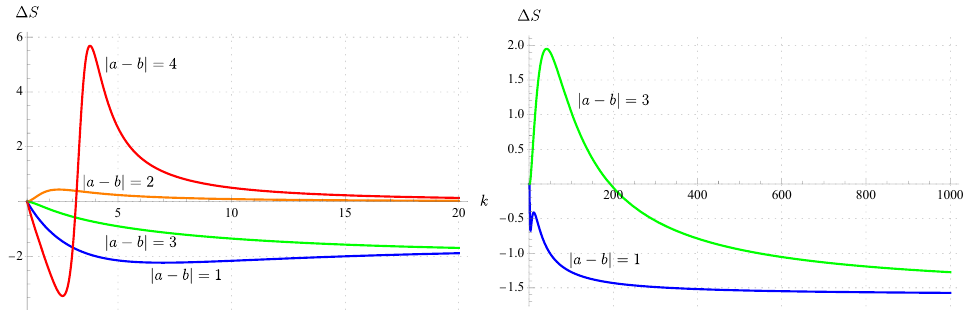
Figure 5 . The difference ∆ S of the pseudo entropy from the averaged entanglement entropy as a function of the levels k when N = 5 . The left panel shows ∆ S of the form (2.57) by the second prescription (2) of analytic continuation. The blue, orange, green and red curves represent the cases with | a − b | = 1 , 2 , 3 , 4 respectively. For comparison, the right panel shows ∆ S of the form (2.50) by a naive prescription (1) when | a − b | is odd. For even | a − b | , ∆ S takes the same values as the left